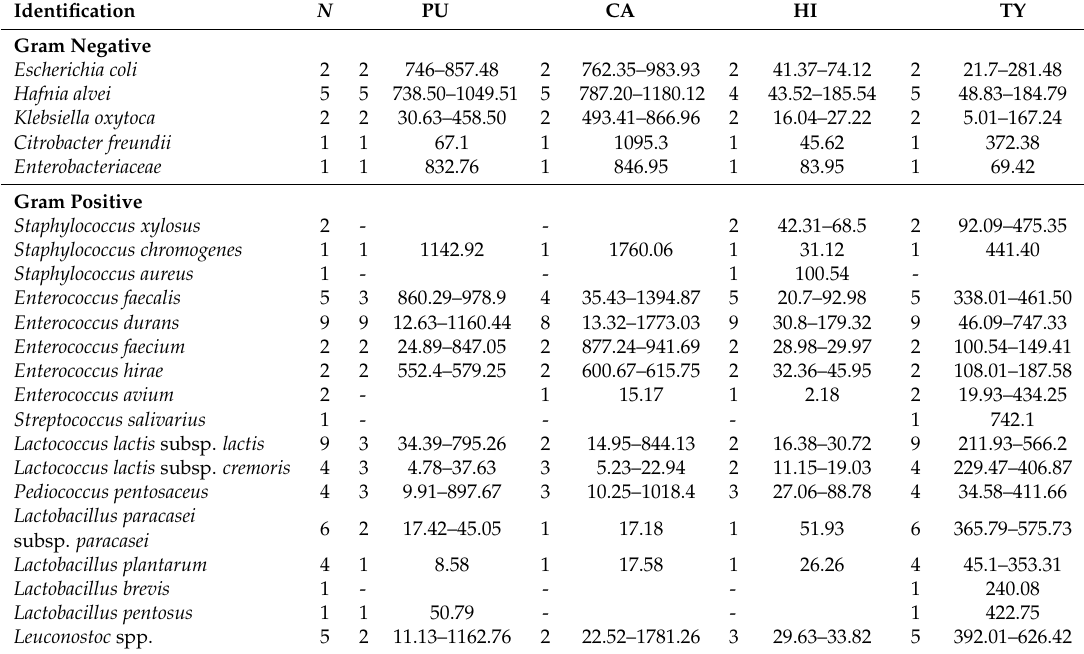
Table 6. Identification of strains obtained from ewe’s raw milk cheeses with decarboxylase activity and their BA production in decarboxylase broths (mg/mL). Results are shown without considering the HHP treatments to which some cheese samples were